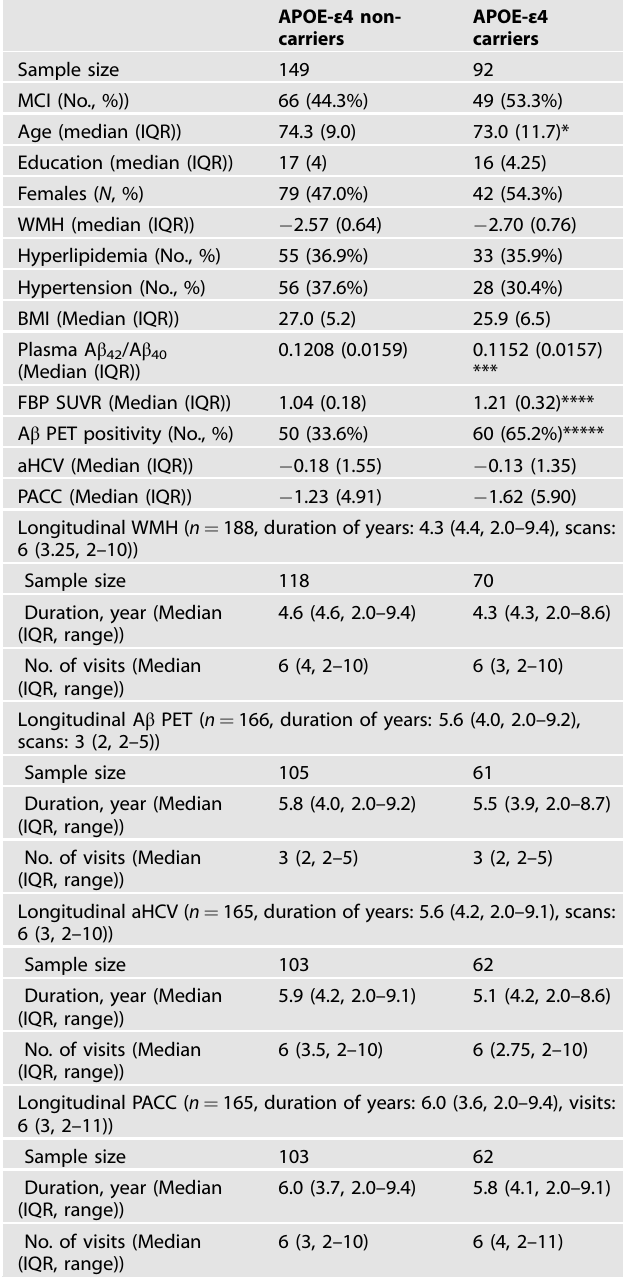
Table 1. Demographics of participants in this